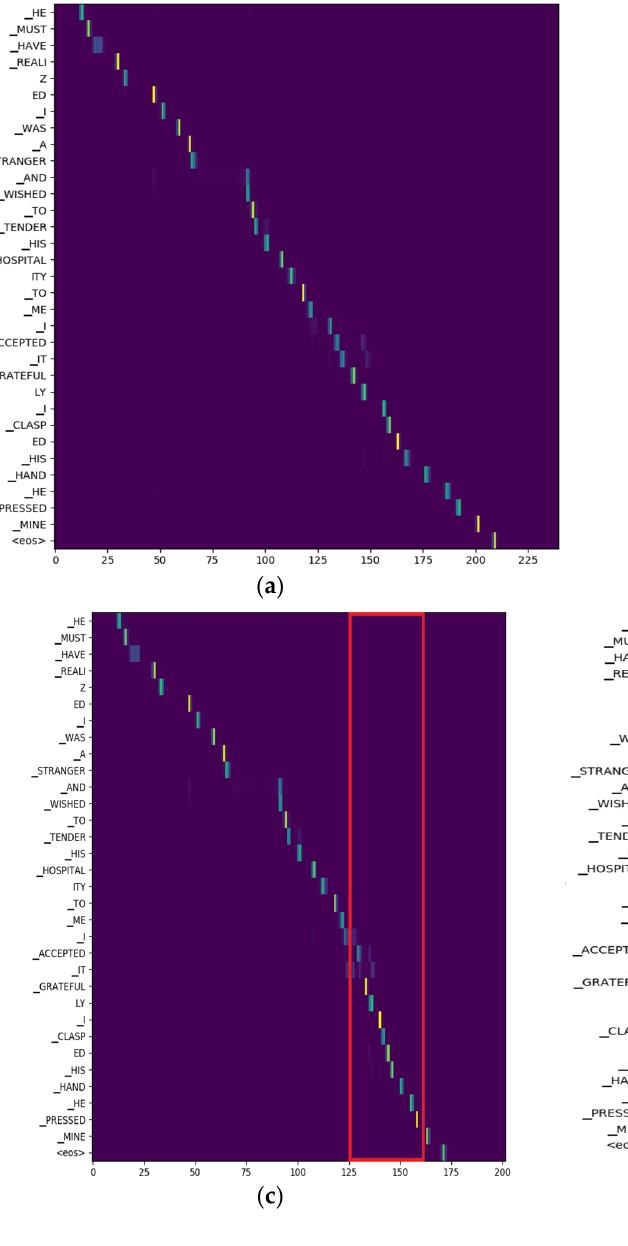
Figure 8. Comparison of the attention alignments with the encoder feature index on x -axis and the outputs on y -axis for the same utterance. We note that speech frames are subsampled by 4:1 for en- coder input of Transformer. ( a ) Original data; ( b ) speed perturbation (speed = 1.1); ( c ) FrameAugment ( s = 0.5, n = 300, p = 500); ( d ) FrameAugment ( s = 1.5, n = 500, p =